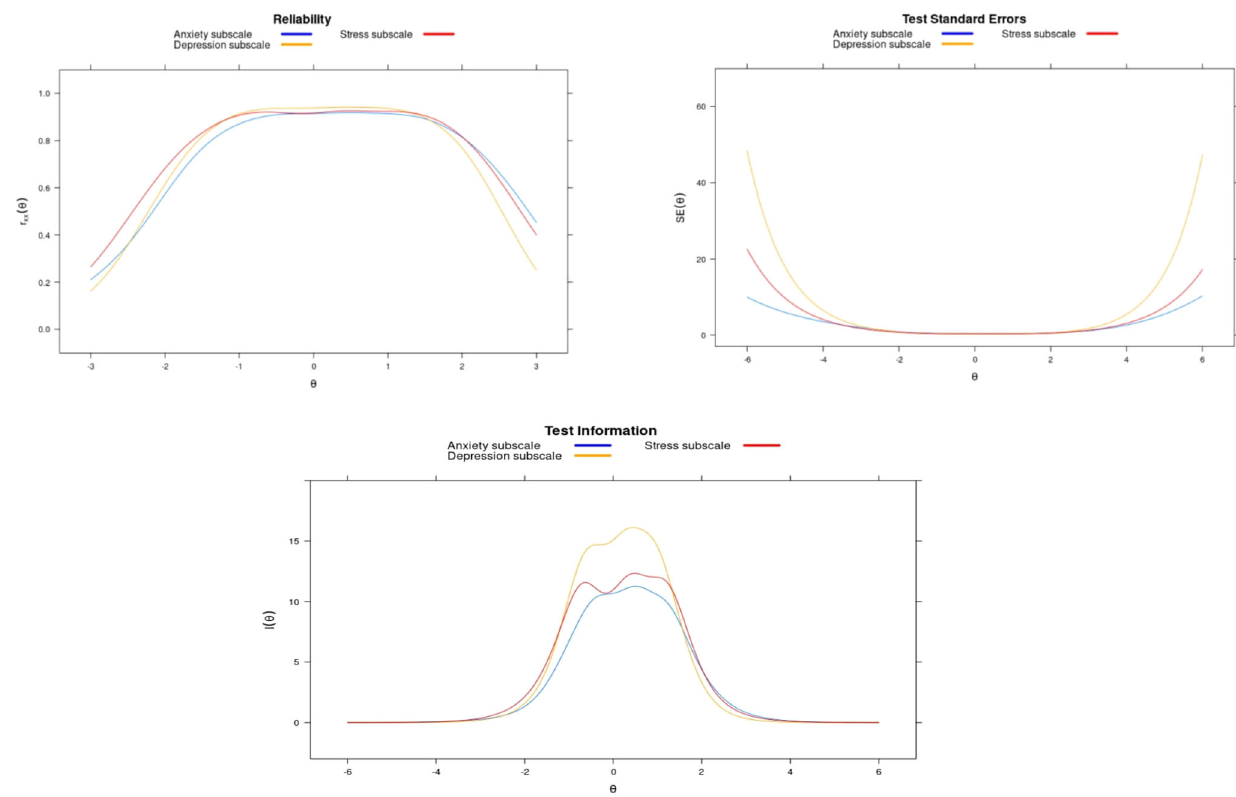
Fig. 1 Test reliability, standard errors, and information function of the DASS-21 subscales (depression, anxiety, and stress subscales are indicated with yellow, blue, and red lines, respectively).